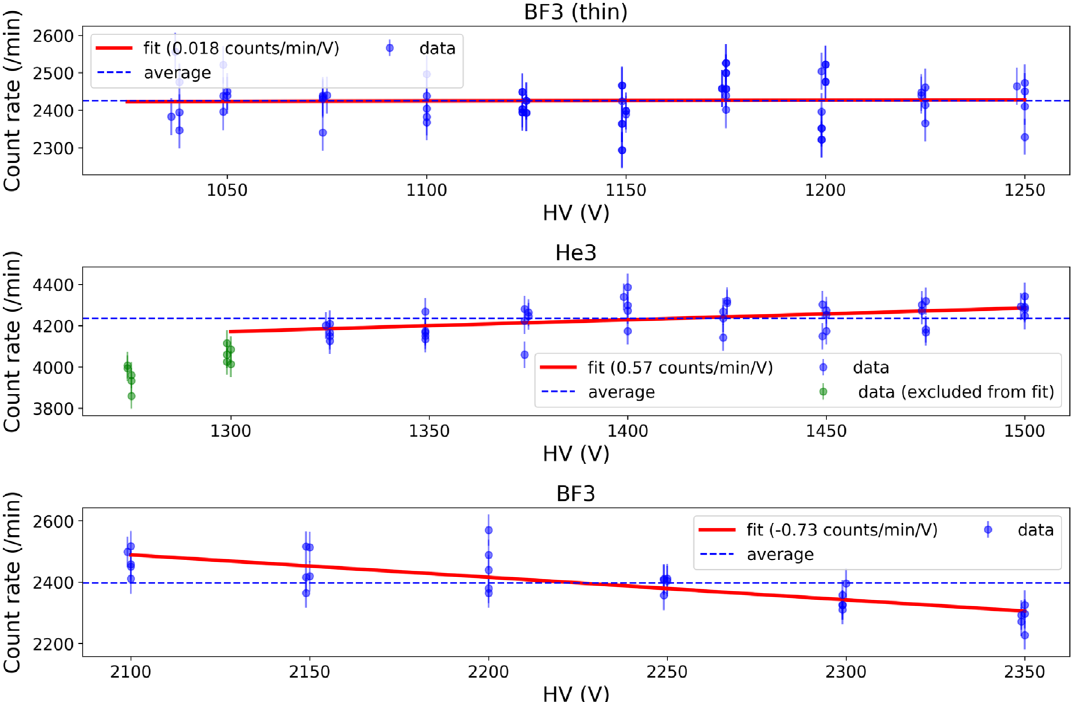
Fig. 6. The dependence of the observed count rate on variations of the HV, as measured for different tubes. The average count rate for each tube is indicated by the dashed line, while the red line shows the results of a linear regression. For the middle panel, green data points were excluded when performing the